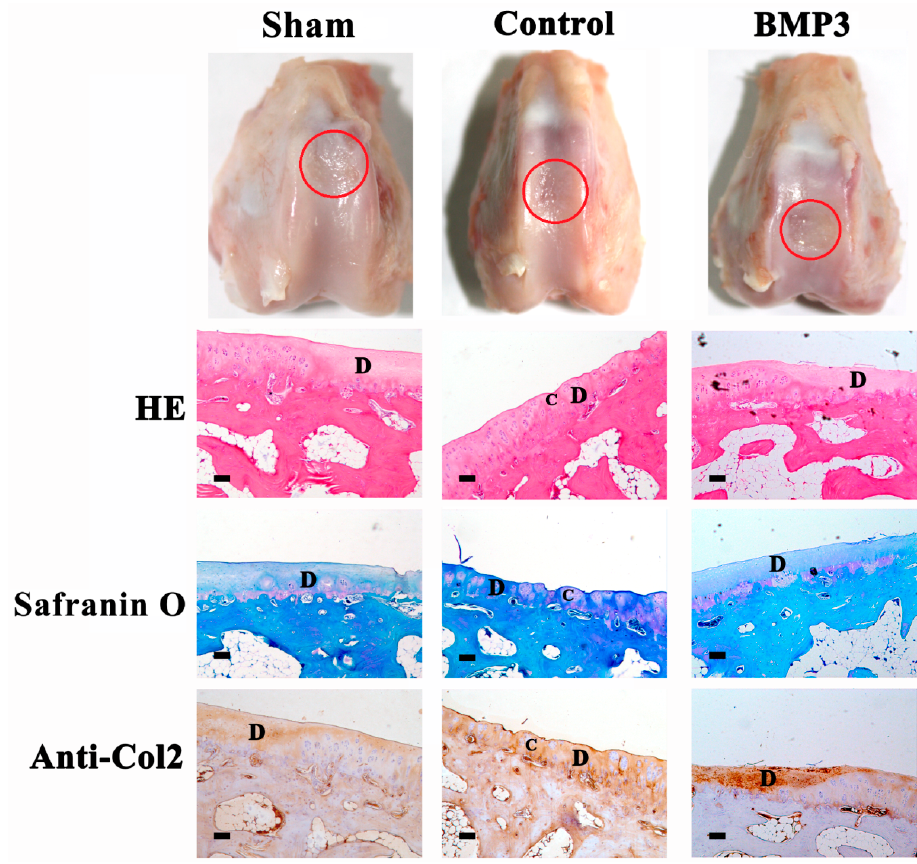
Figure 1. Macroscopic and histological examinations of the repaired tissue in partial-thickness defect at eight week post-operation. The red circle regions are the defects of articular cartilage. Sections were stained with hematoxylin and eosin (HE), Safranin O, or immunohistochemical collagen type II (Anti-Col2). Sham, sham-operated group; Control, group only treated with collagen membrane without BMP3 as negative control; BMP3, group treated with the collagen membrane and BMP3 at 100 ng/cm 2 , respectively. D and C stand for defect area and chondrocyte-like cells, respectively. Scale bar is 100 µ